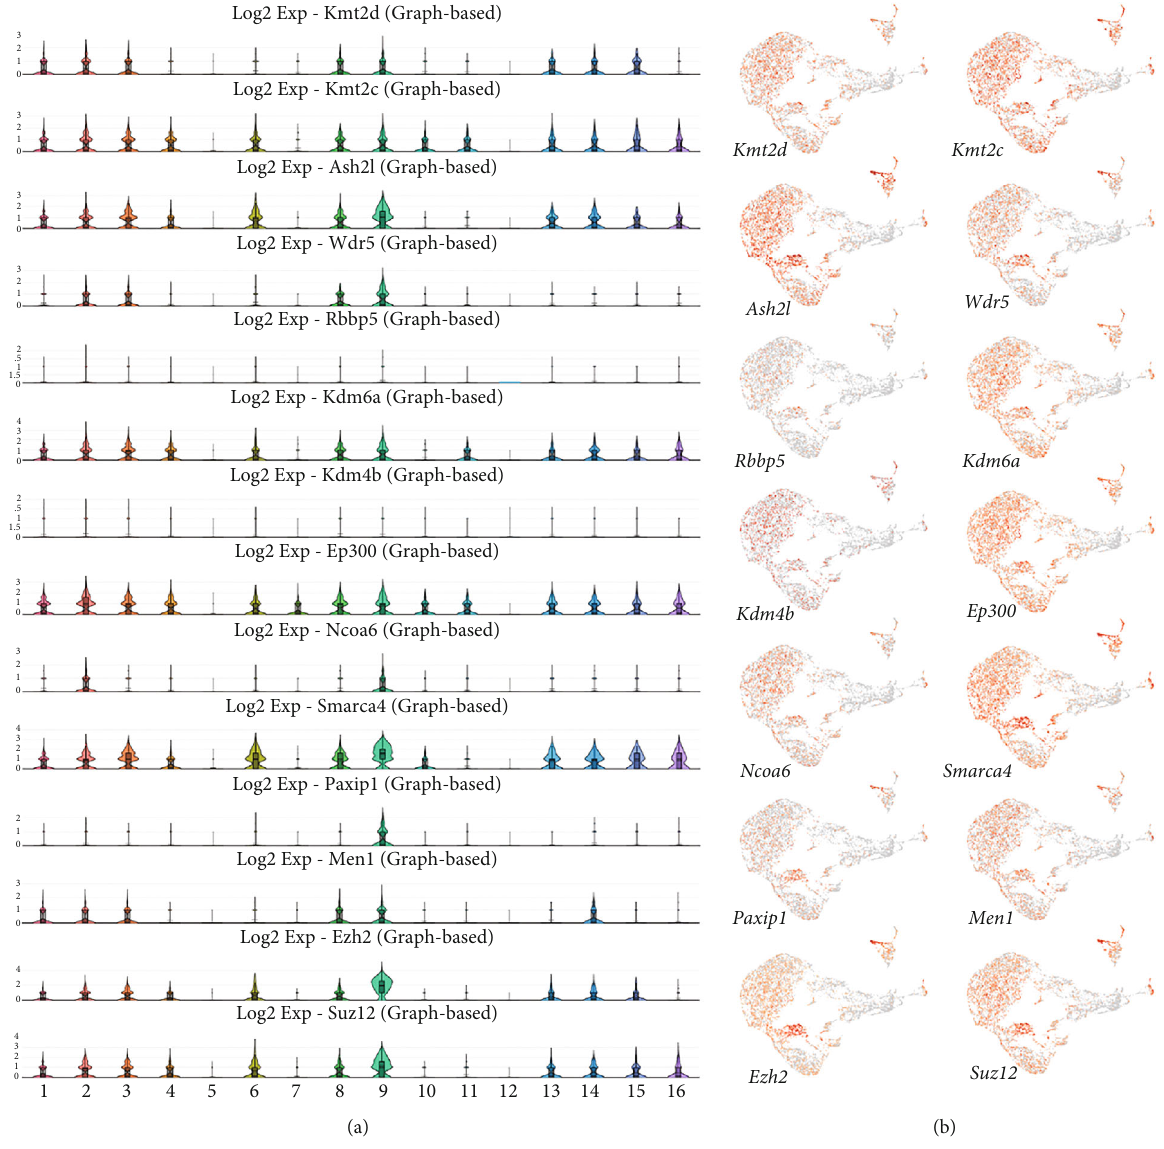
Figure 2: Expression of genes encoding proteins associated with KMT2D and KDM6A. (a) Violin plots of genes encoding KMT2C, ASH2L, WDR5, RBBP5, KDM4B, p300, NCOA6, SMARCA4, PAXIP1, MEN1, EZH2, and SUZ12. (b) UMAP visualization of genes encoding components of the SET1/COMPASS and PRC2